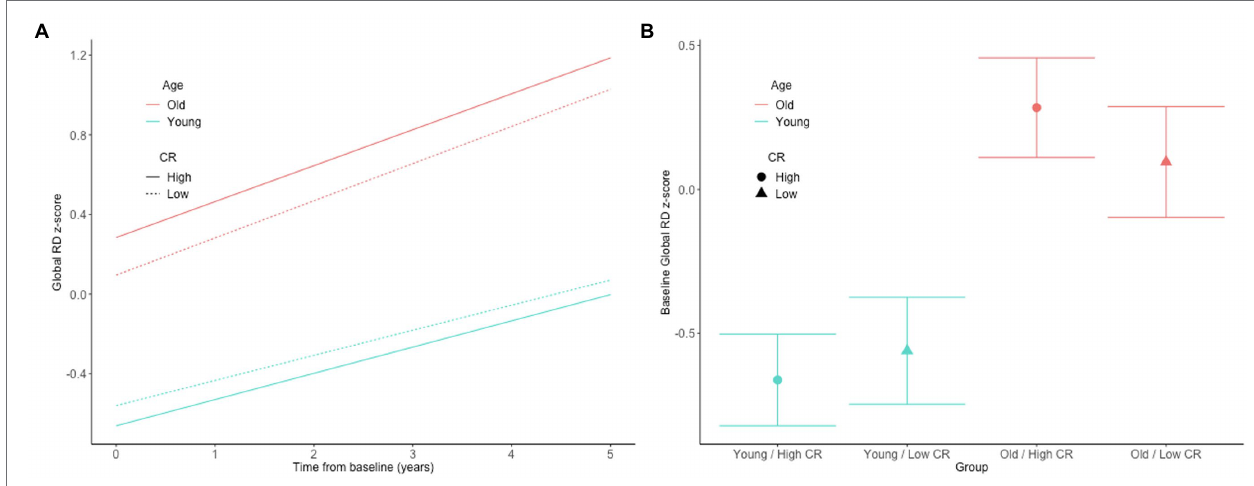
FIGURE 1 | Estimates of the association between CR composite scores and age in relationship to longitudinal change in (A) and baseline level of (B) white matter microstructure, as measured by global RD in the full, non-demented sample. The CR composite score and age were dichotomized by median split for illustration purposes, but treated as continuous variables in the linear mixed effects